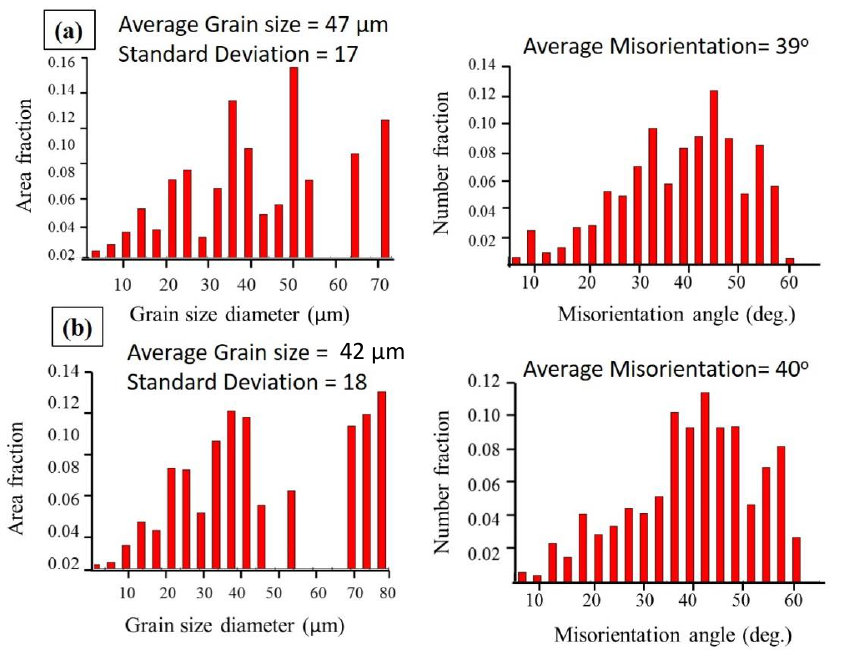
Figure 11. Grain size distribution and misorientation angle distribution of BMs, where ( a ) AA2024- T4and ( b ) AA7075-T6.